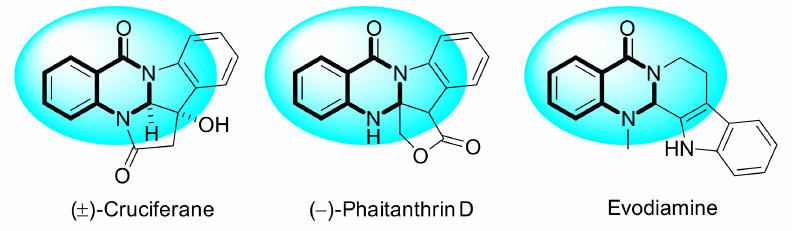
Figure 1. Bioactive fused dihydroquinazolinone